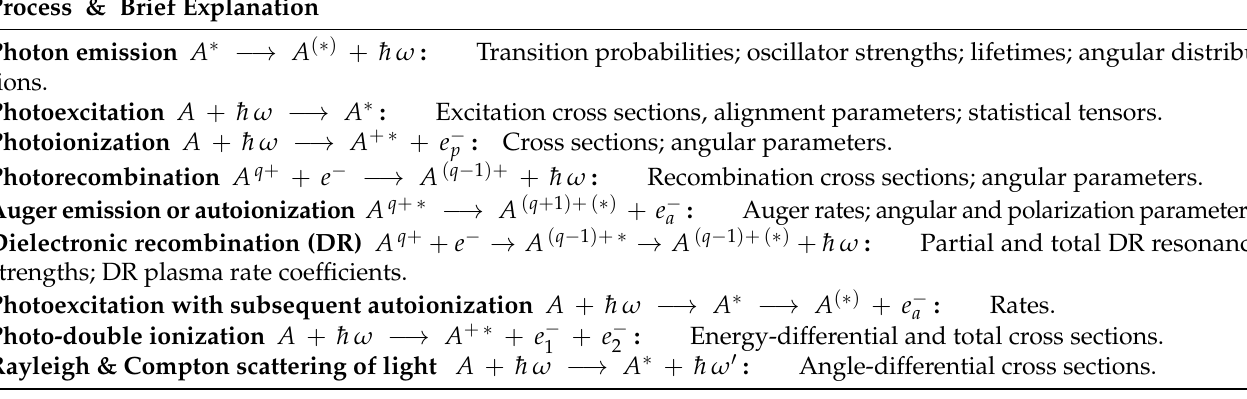
Table 2. Selected excitation, capture and decay processes that can be calculated by means of the J AC toolbox. A ∗ refers to the excitation and A ( ∗ ) to some possible excitation of an atom or ion with regard to its ground